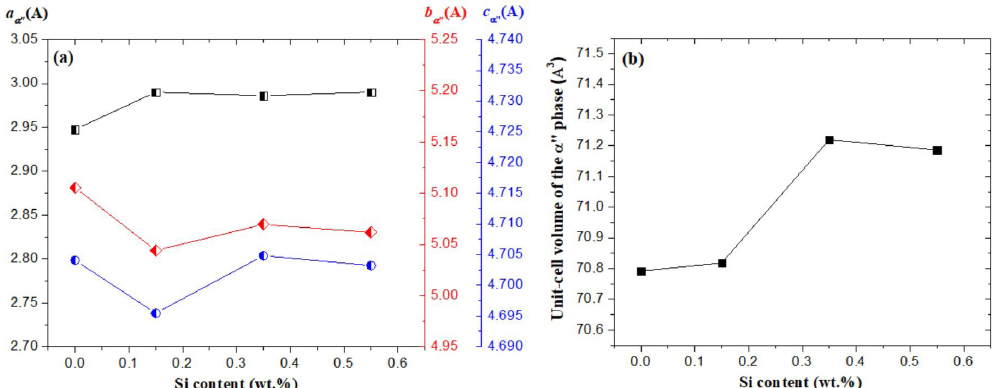
Figure 7. Variation of the lattice parameters (a) and unit-cell volume (b) of the α” phase as a function of Si content for WQ Ti-15Nb-xSi samples.